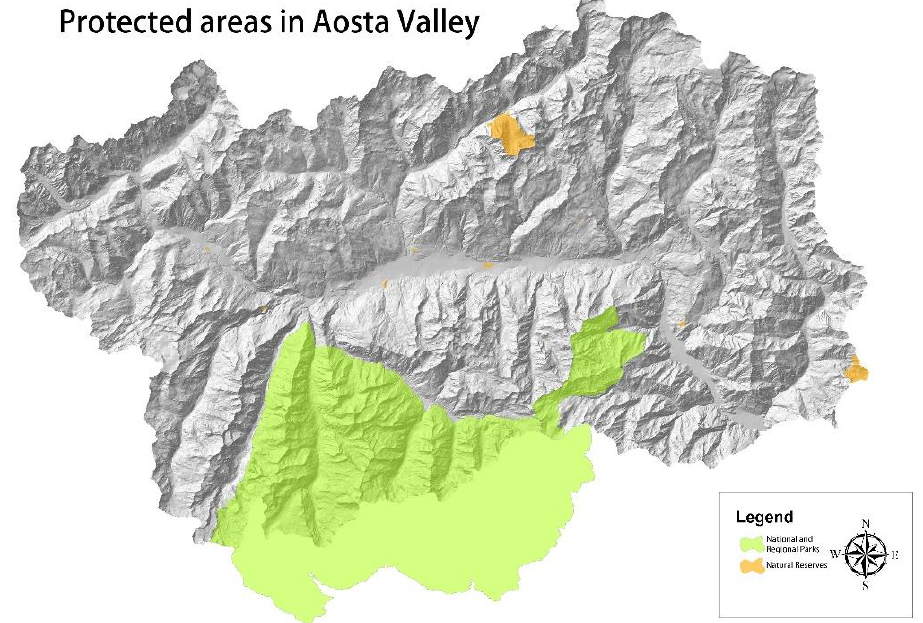
Figure 3. Protected areas in Aosta Valley including parks (green) and reserves (orange).